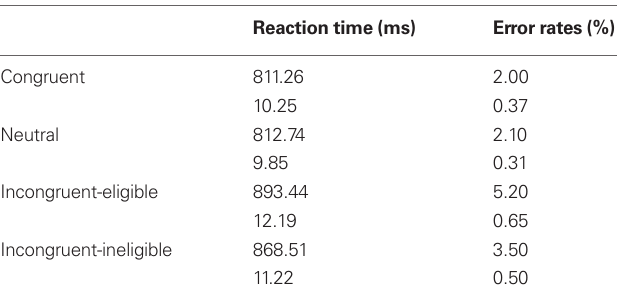
Table 1 | Mean reaction time and error rates for all conditions of the Stroop